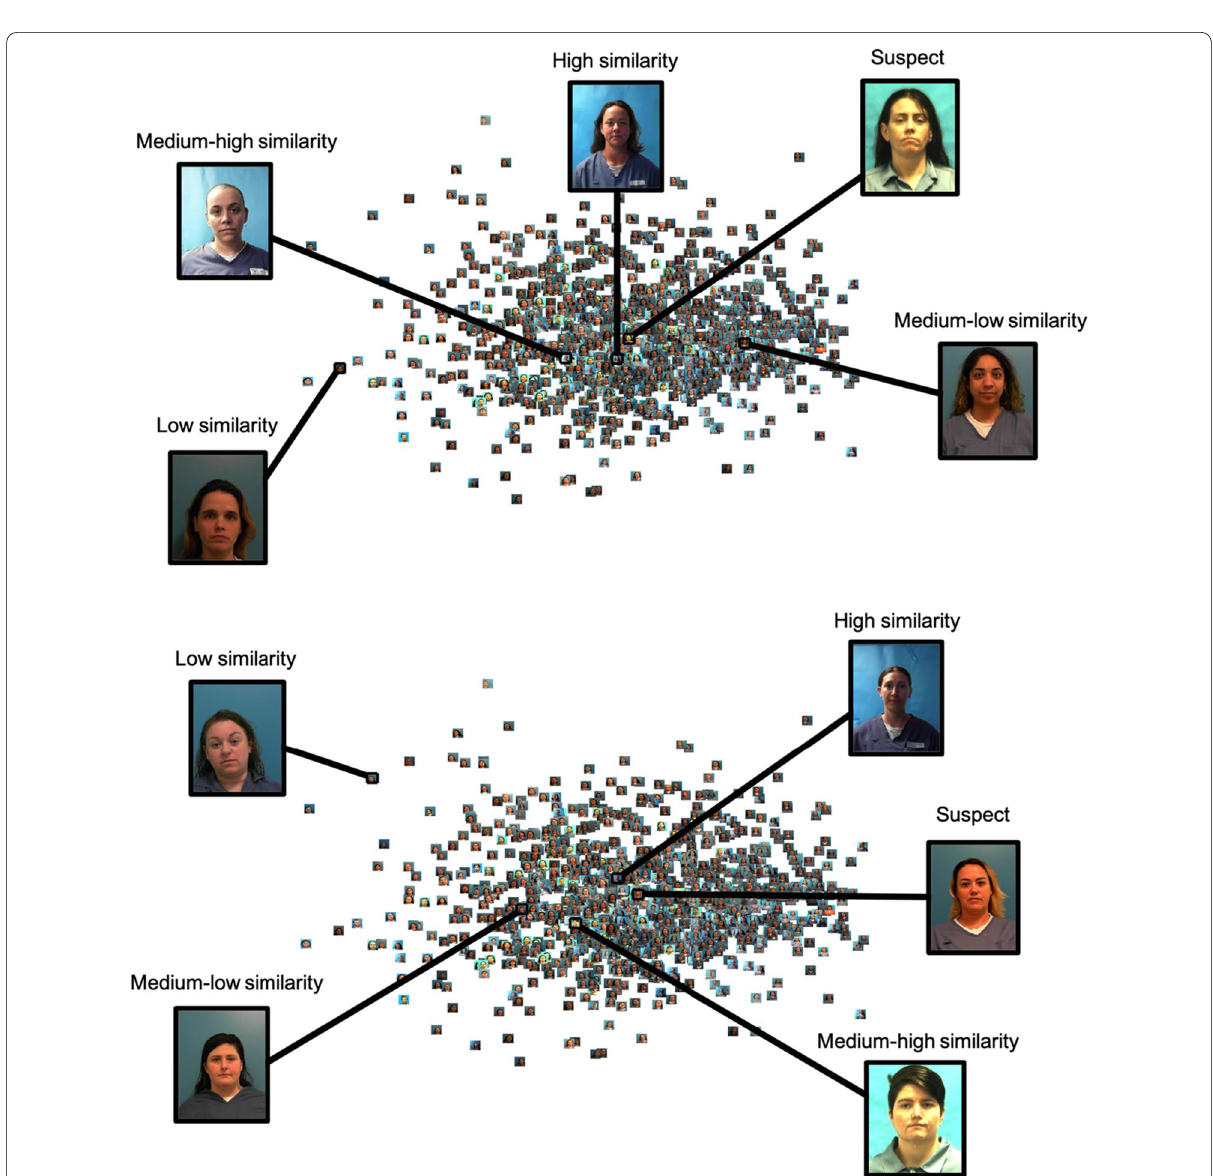
Fig. 2 A two-dimensional face space of white females in their 30 s. Each panel shows an example of a suspect, with a potential filler for each level of similarity, based on distance from the suspect. The top panel shows an example using a randomly determined guilty suspect. The bottom panel shows an example using a randomly determined innocent suspect. Note: Two dimensions were specified for these spaces for illustrative purposes